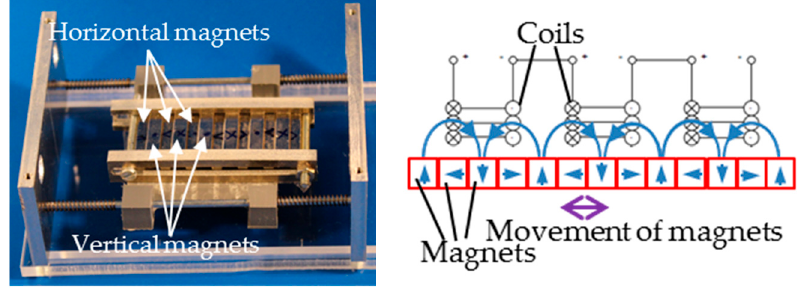
Figure 3. Photo ( left ) and principle ( right ) of the Halbach arrangement of 13 magnets on the slider.